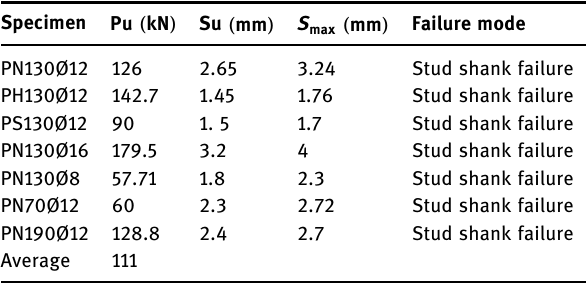
Table 6: Pushout test results for group II smooth surface specimen